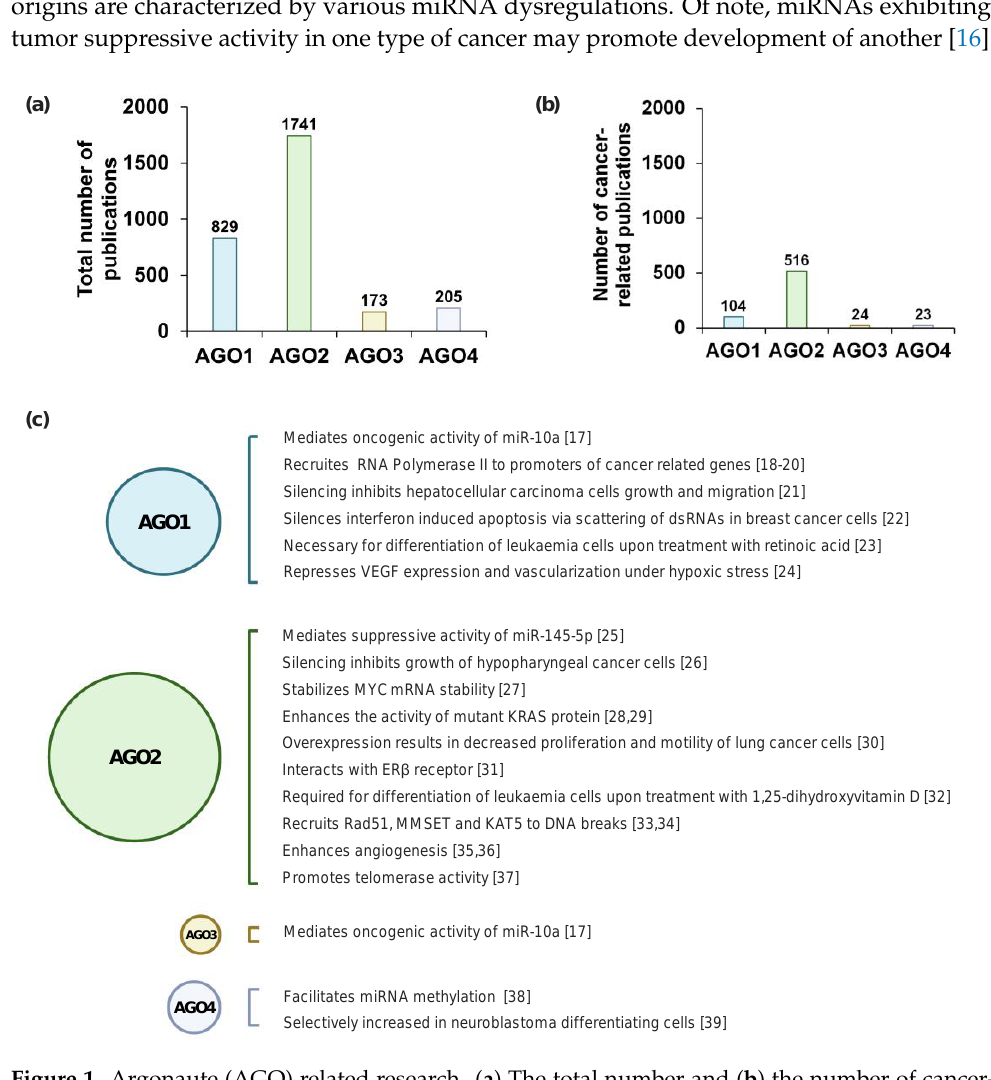
Figure 1. Argonaute (AGO) related research. ( a ) The total number and ( b ) the number of cancer-related studies of AGO1–4 found in PubMed using keywords “AGO1/AGO2/AGO3/AGO4” and “cancer”, until 13 January 13 2021. ( c ) Highlighted studies that show the detailed molecular mechanisms of AGO1–4 in cancer-related processes, based on ref [17–39]. Created with BioRender.com (accessed date: 21 January 2021).